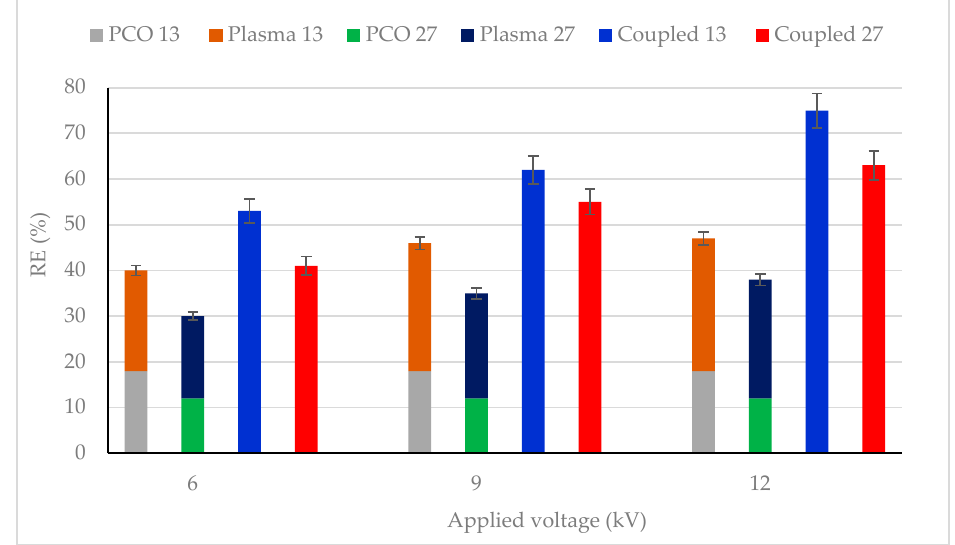
Figure 3. CB removal efficiency for photocatalysis, plasma–catalysis and photocatalysis–plasma– catalysis combined process. CB inlet concentration: 13 and 27 mg/m 3 , Flow rate: 0.25 m 3 /h, RH: 5%, Temperature: 20 °C, Plasma applied frequency: 50 Hz.